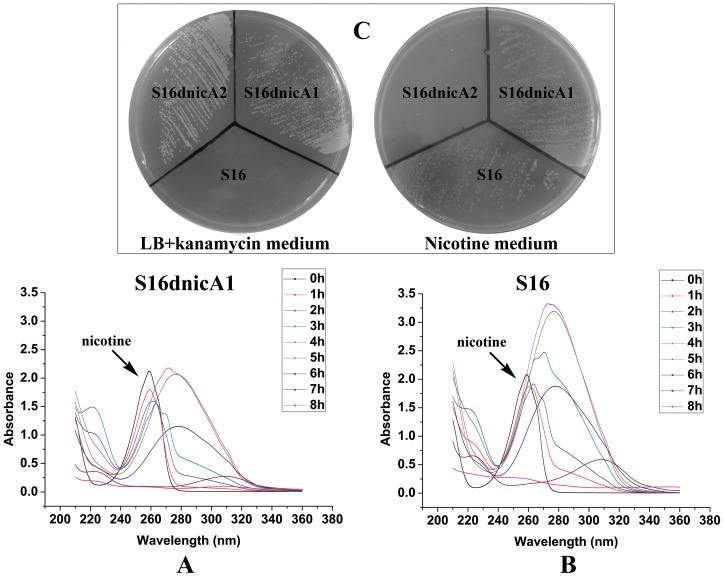
Cell growth and resting cell reactions of strain S16 and the gene deletion mutant S16dnicA1.
A. UV-scan analysis of nicotine degradation by resting cell of gene deletion mutant S16dnicA1. B. UV-scan analysis of nicotine degradation by resting cell of strain S16. C. Strain S16, gene deletion mutant S16dnicA1, and gene deletion mutant S16dnicA2 grown on a nicotine plate containing nicotine as the sole carbon and nitrogen source, and on a LB plate containing kanamycin.